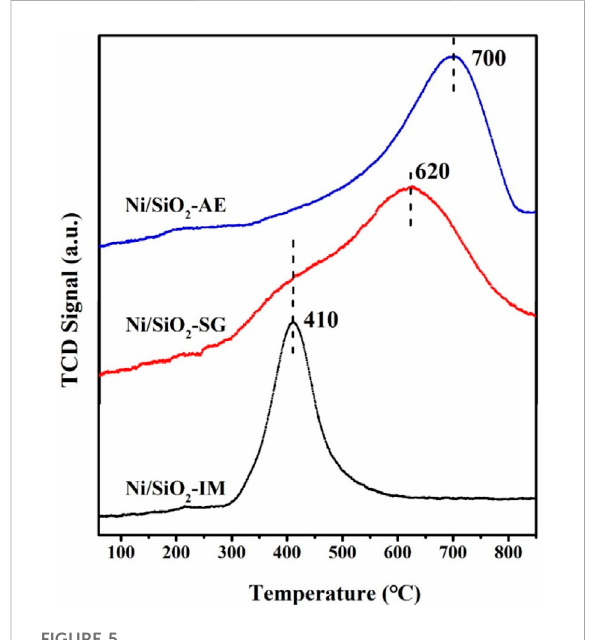
FIGURE 5 The H 2 -TPR pro fi le of Ni-based catalysts.